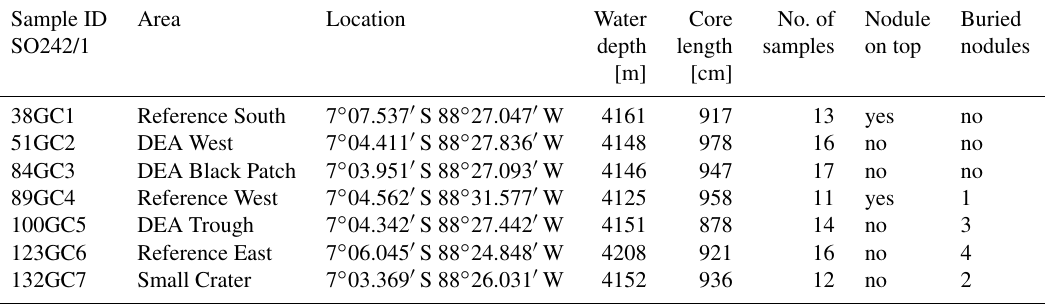
Table 1. Overview of sampled cores. Sample ID